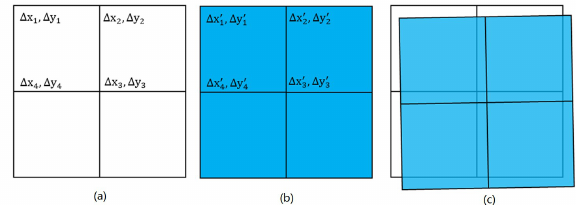
Figure 2. The algorithm flow of high resolution DEM data coordinate system transformation.